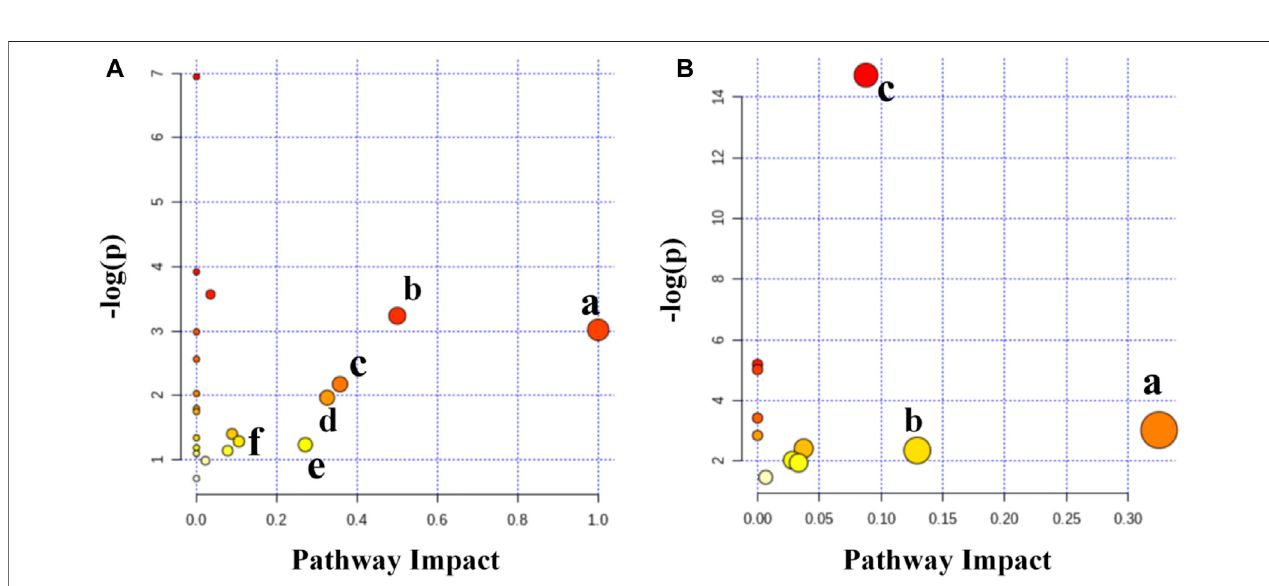
FIGURE 9 | (A) Summary of pathway analysis in the spleen. (a) Linoleic acid metabolism, (b) phenylalanine, tyrosine, and tryptophan biosynthesis, (c) phenylalanine metabolism, (d) starch and sucrose metabolism, (e) glycine, serine and threonine metabolism, and (f) glyoxylate and dicarboxylate metabolism. (B) Summary of pathway analysis in the serum. (a) Starch and sucrose metabolism, (b) inositol phosphate metabolism, and (c) galactose metabolism.